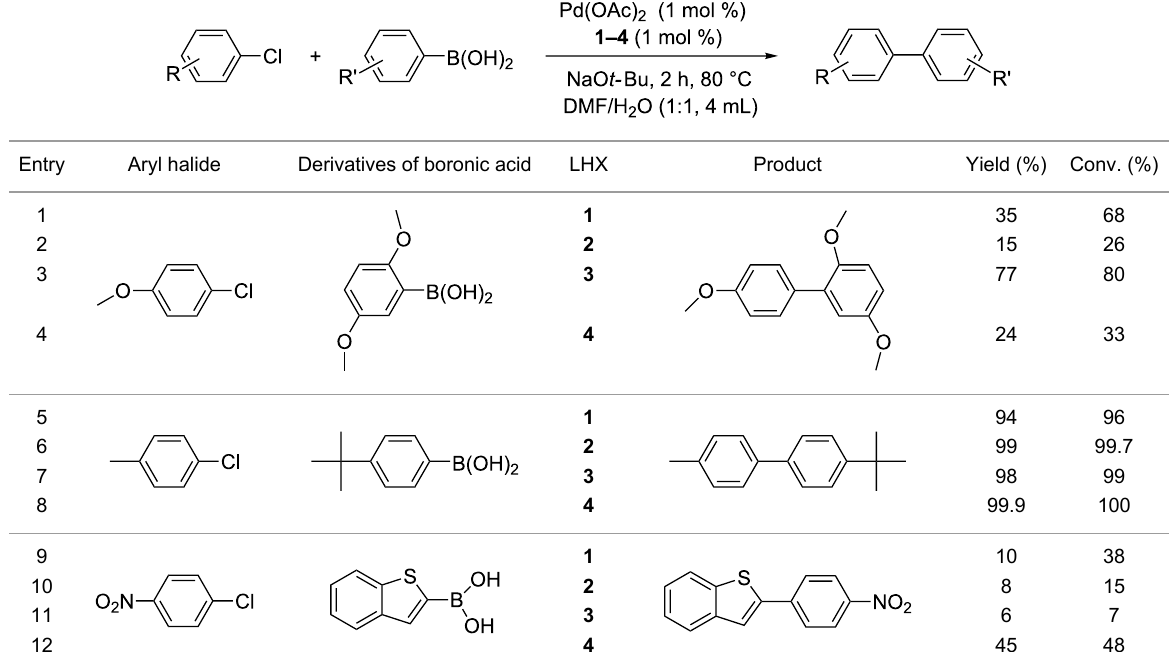
Table 3: Suzuki–Miyaura cross-coupling reaction of boronic acid derivatives with aryl halides a,b .